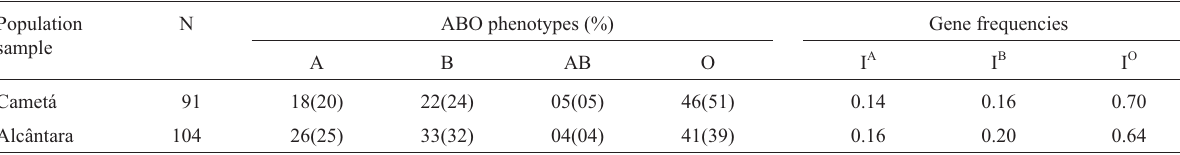
Table I - Distribution of ABO blood group phenotypes and gene frequencies in Brazilian Black populations. Population sample